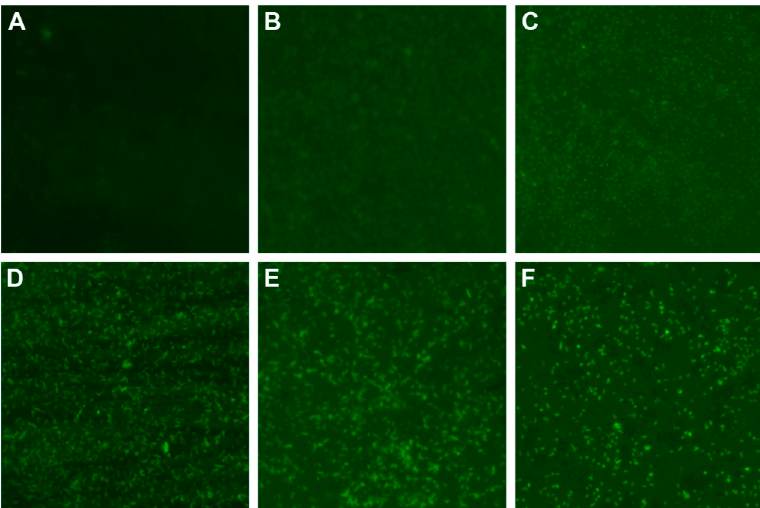
Figure 7. Changes of reactive oxygen species (ROS) production in AgNPs-treated multidrug-resistant Pseudomonas aeruginosa at different time intervals under fluorescence microscopy with ×400